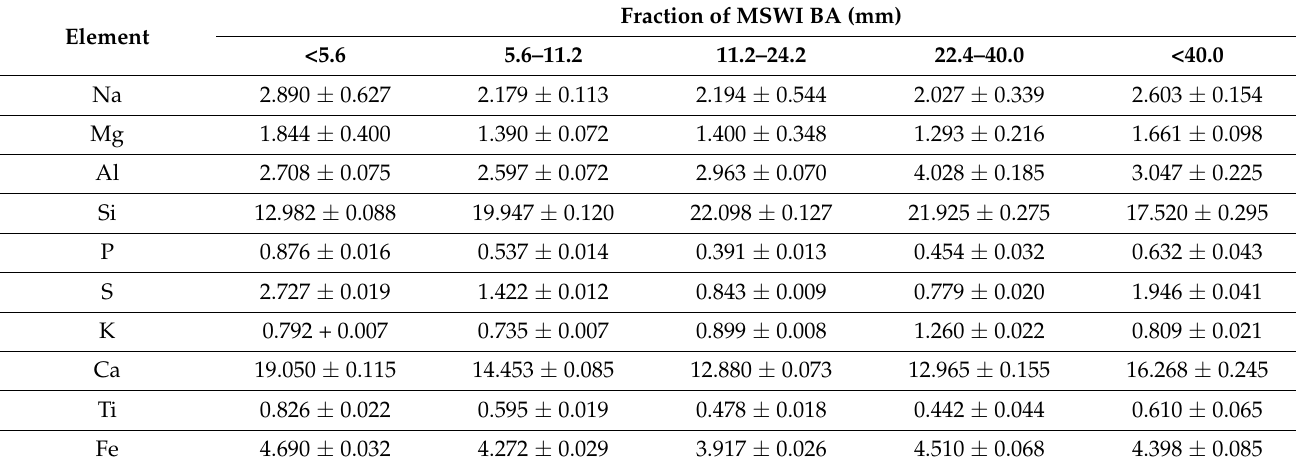
Table 1. Major elements of five different fractions of untreated MSWI bottom ash (wt %).